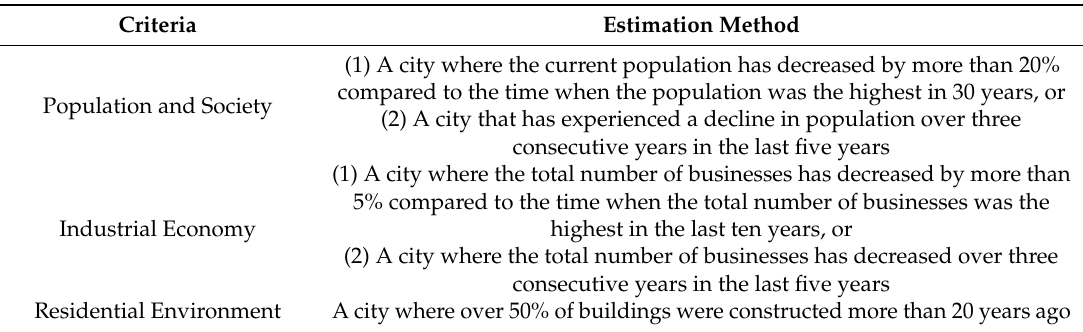
Table 3. Estimation method for city